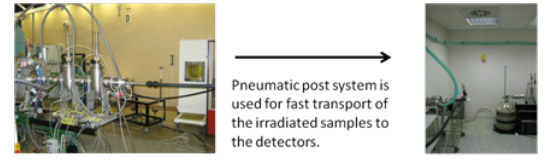
Figure 8. Measurement of γ activation after irradiation Figure 6. The proton recoil telescope arrangement